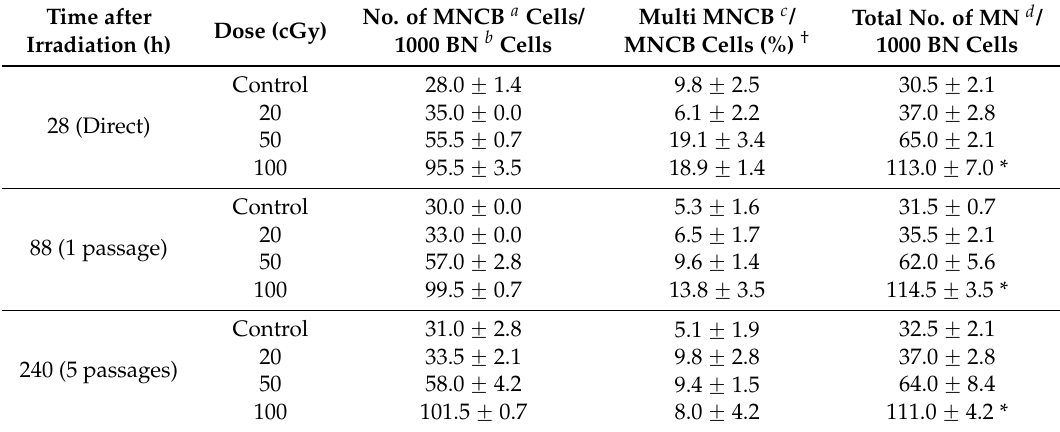
Table 1. The frequencies of micronuclei in the X-irradiated fibroblasts at all time points. Time after Irradiation